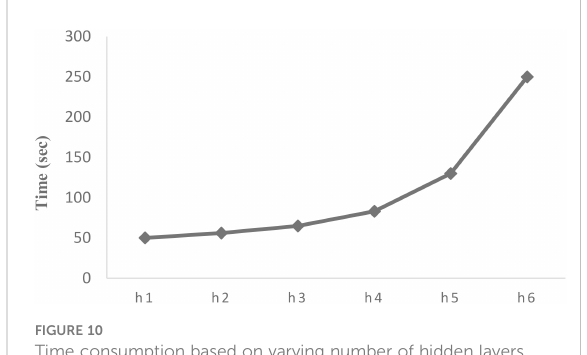
FIGURE 10 Time consumption based on varying number of hidden layers.